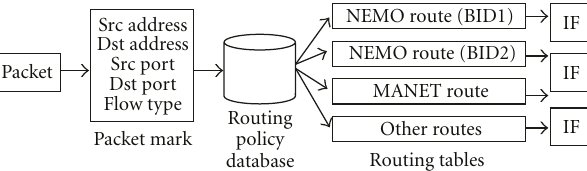
Figure 6: Policy routing. Depending on several criteria, each packet is routed according to one of several routing